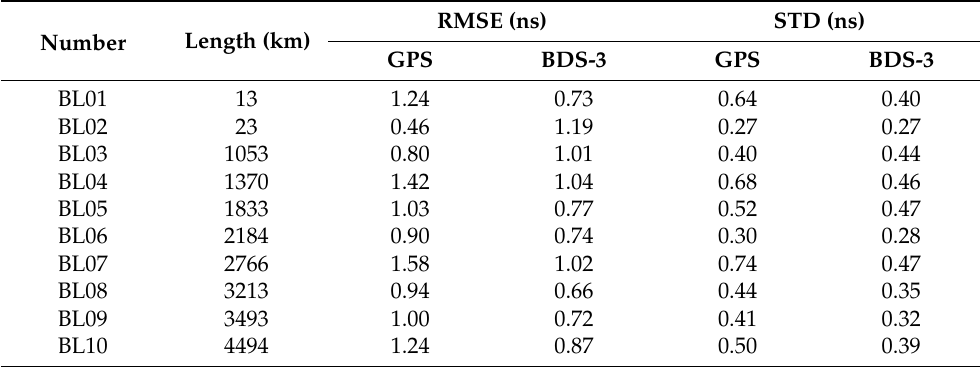
Table 3. Average RMSEs of time synchronization from 10 baselines.